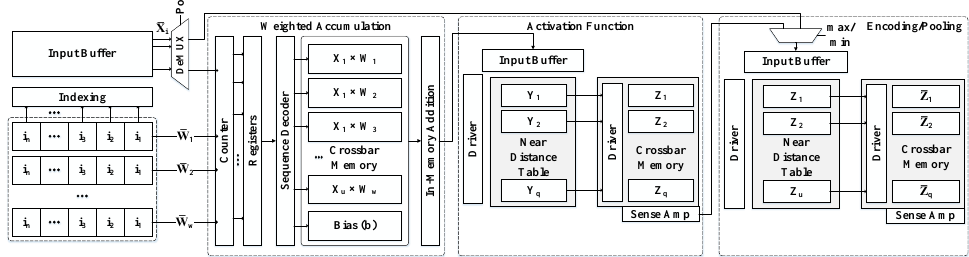
Figure 25. Architecture of an RNA block in the RAPIDNN accelerator (adapted from